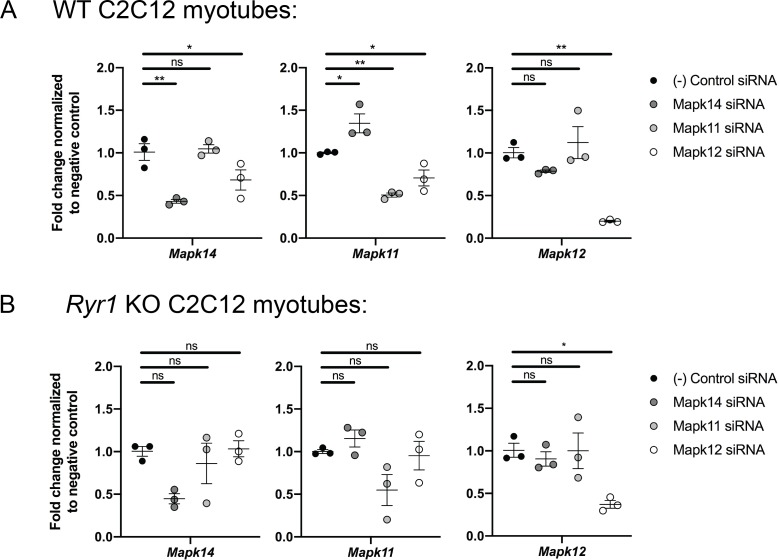
Quantitative PCR analysis was performed to validate the efficiency of siRNA knockdown of three p38 MAPK genes in both WT and Ryr1 KO myotubes.As shown, the siRNAs reduce target gene expression by >50% in WT cells (A) while the degree of knockdown achieved in Ryr1 KO myotubes (B) was more variable. Data are presented as mean ± SEM fold change for n = 3 independent myotube cultures. Statistical analysis by one-way ANOVA followed by Holm-Sidak’s multiple comparisons post-test to compare each group to the negative control siRNA. *p<0.05, **p<0.01, ***p<0.001.